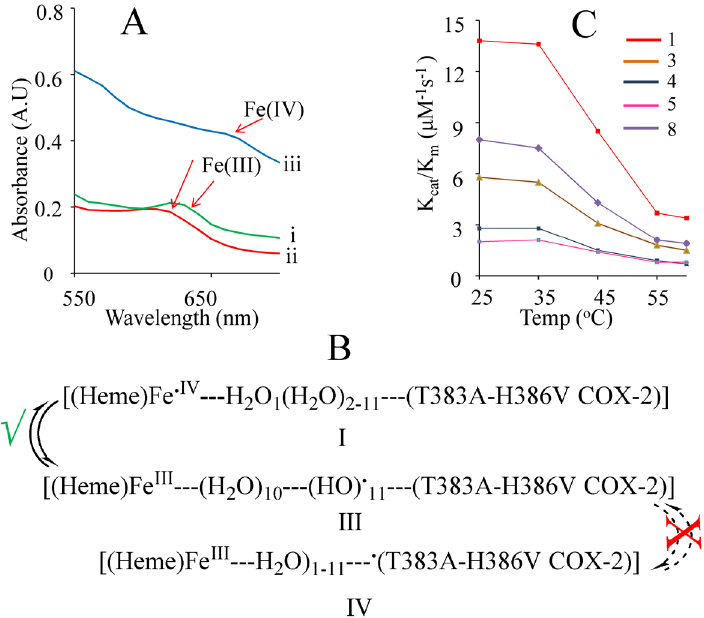
Figure 5. Experimental studies with wt- and mu-COX-2: ( A ) UV–vis spectra of T383A-H386V muCOX-2 reaction: (i) no AA, (iii) AA, (ii) after 5 min of AA addition. ( B ) schematic representation of blockage of H · /e